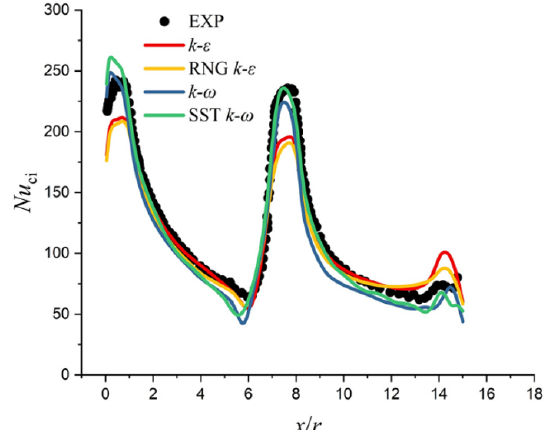
Figure 7. Comparison of Nusselt number on the plate centerline at Re j = 35,000 and H / D j = 3.